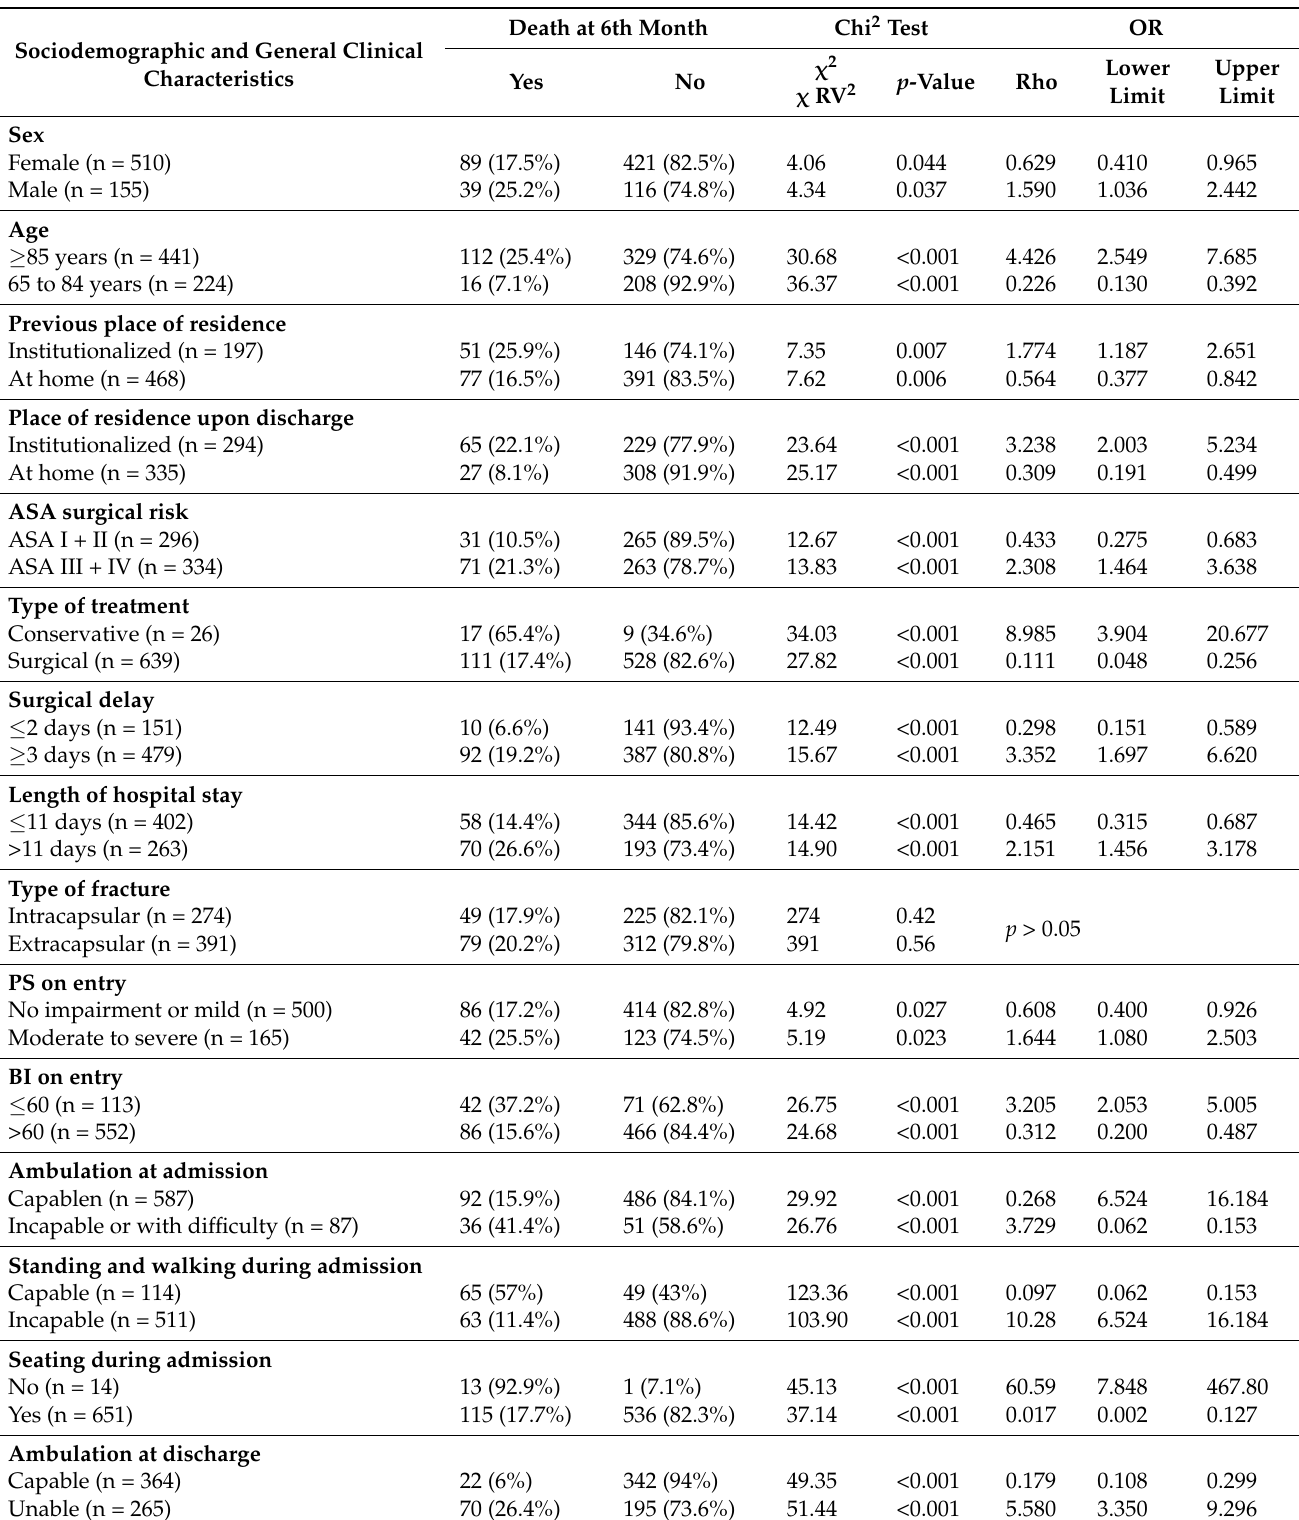
Table 1. Chi 2 test results between mortality at sixth month and relevant sociodemographic and clinical